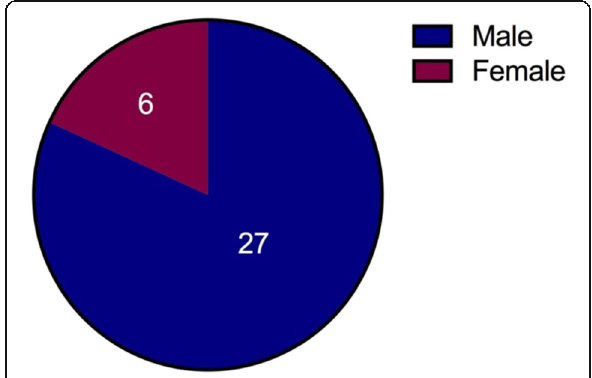
Fig. 1 Our patients were predominantly males, with a male to female ratio 4.5:1. Of the 33 patients, 81% were